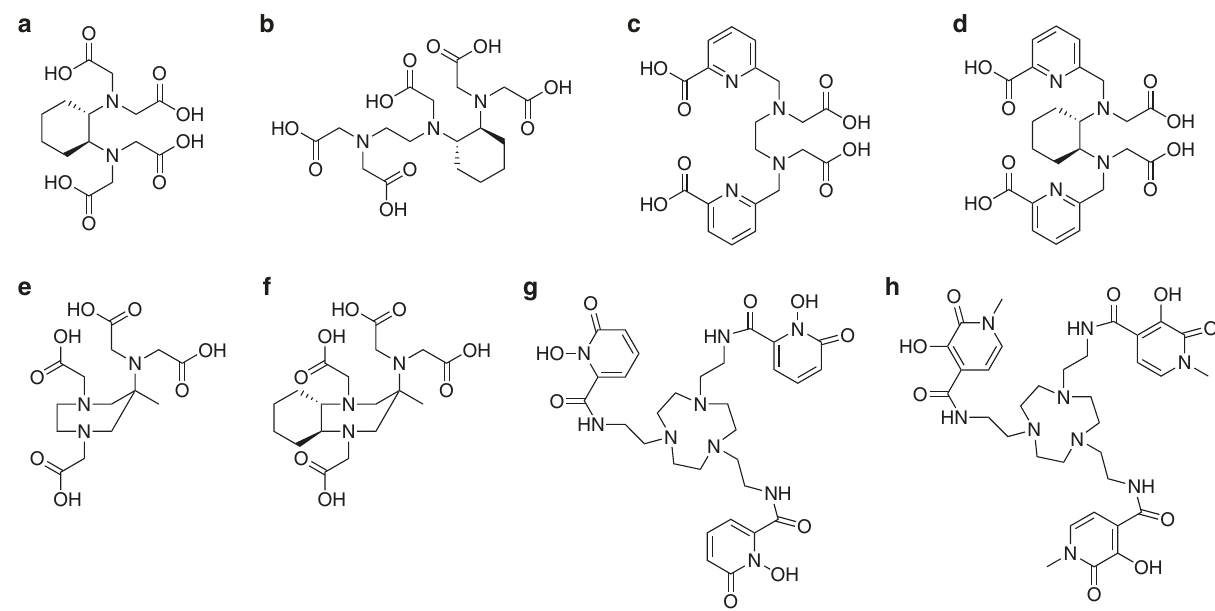
Fig. 8 Acyclic ligands where rigidi fi cation has been introduced into the ligand framework. a H 4 cdta, featuring rigidi fi cation by a cyclohexyl motif. b H 5 chxdtpa, where a cyclohexyl derivative has also been included into the ligand backbone. c H 4 octapa, featuring two picolinic acid binding motifs giving octadentate ligand binding. d H 4 chxoctapa, another octadentate ligand again featuring cyclohexyl substitution for rigidi fi cation. e H 4 aazta, a heptadentate ligand based on an unusual seven-membered ring. f H 4 cyaazta, based on the seven-membered ring motif with additional use of a cyclohexyl group. g , h H 3 tacn-1,2-hopo and H 3 tacn-3,2-hopo, where a small N3-azamacrocycle motif is introduced to aid rigidi fi cation but not to aid in the Gd(III)